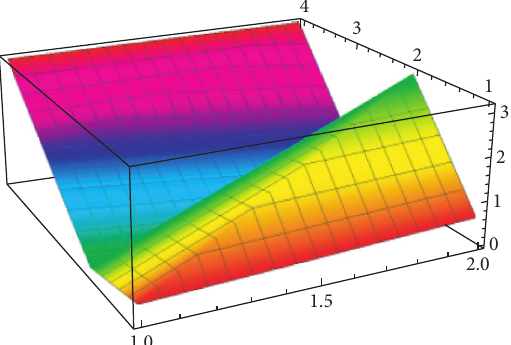
Figure 1: The graphical surface represents a 3-D view of the function, qp